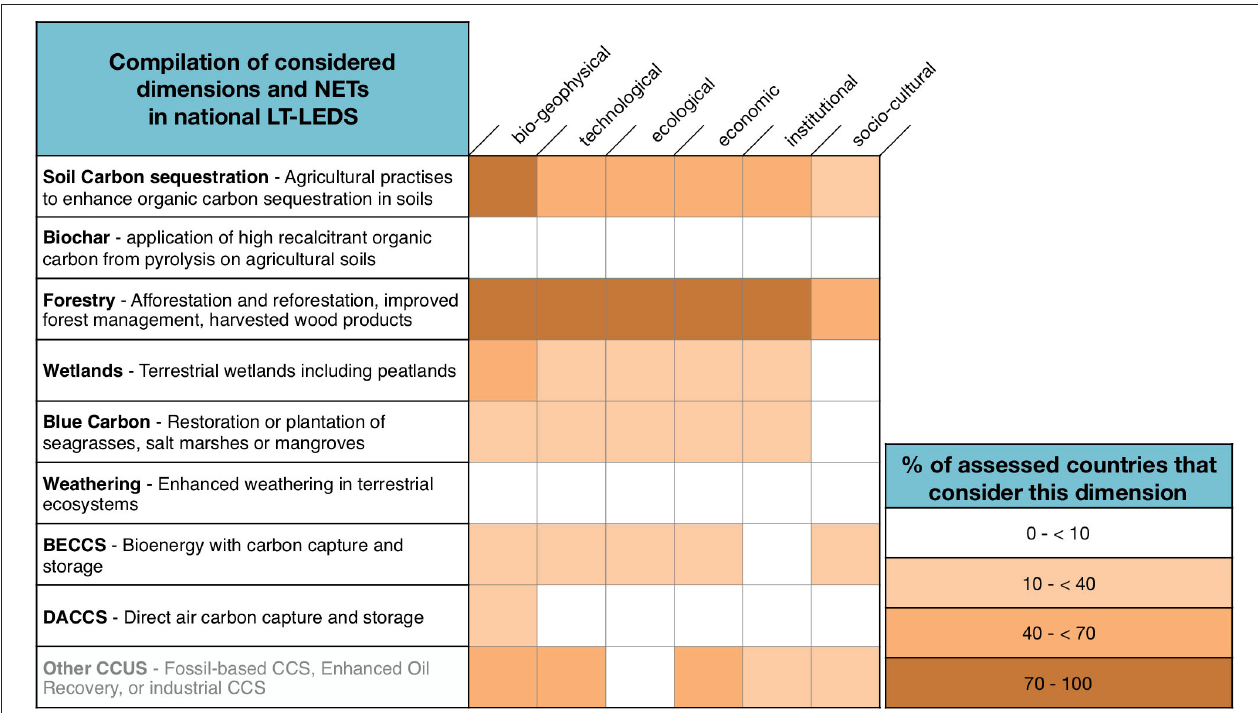
FIGURE 1 | Percentage of Long-Term Low Greenhouse Gas Emissions Development Strategies (LT-LEDS) that cover a given NET, considering one of six feasibility dimensions. This is a compilation of the analysis from Table 1 , the percentage is calculated as the number of LT-LEDS that include ( = 1) or mention ( = 0.5) a NET and feasibility dimension, relative to the total number of considered LT-LEDS, excluding Benin and the Marshall Islands ( N = 15). The category “other CCUS” in gray refers to CCUS techniques without bioenergy. These do not produce negative emissions, but are included as reference based on their interlinkage with BECCS (see also section NETs at the National Level: Insights From 17